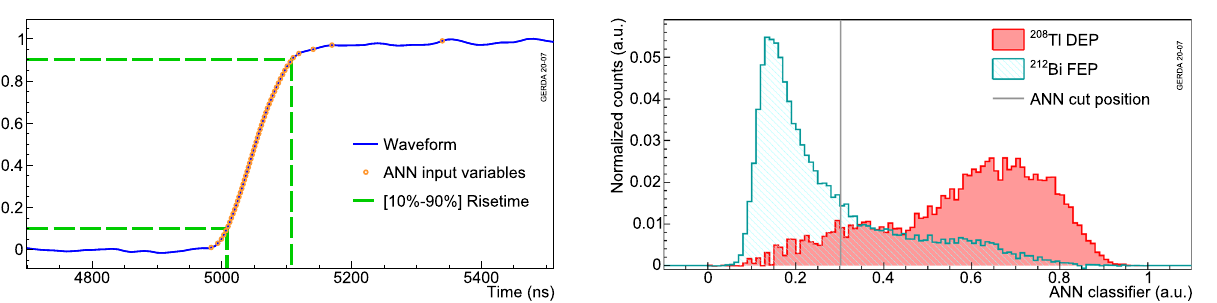
Fig. 12 Trained ANN classifier values for events in the 208 Tl DEP (SSEs)and 212 BiFEP(MSEs)fromtheANG5detector.Thehistograms are normalized to their integrals